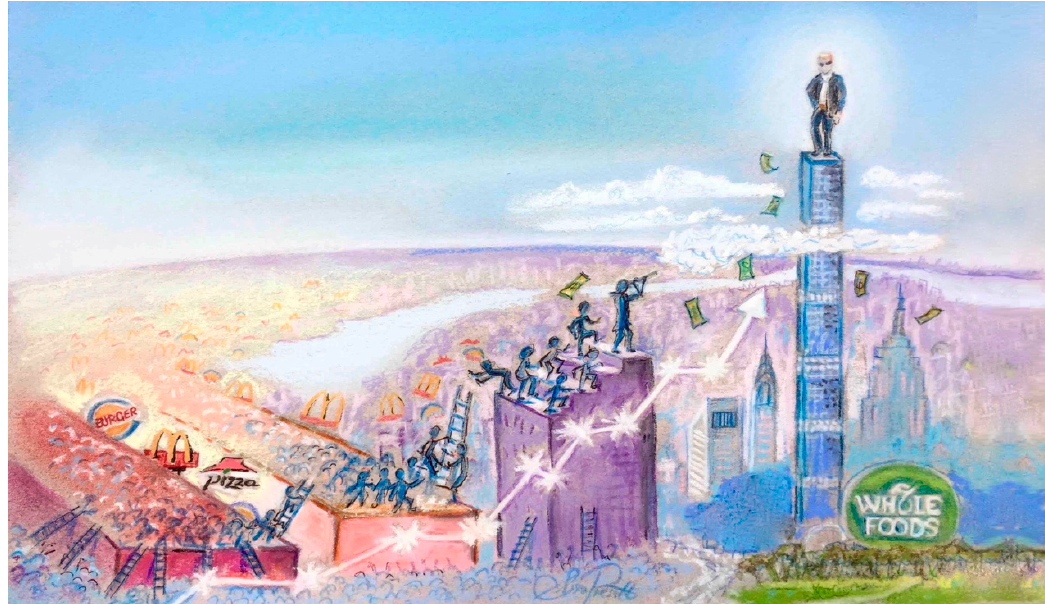
Figure 3. Neoliberal ideologies dominate social, cultural, political, and scientific narratives: Promote possessive individualism, acquisition, competition, and ownership, which perpetuate extreme socioeconomic gradients and vast health inequalities.